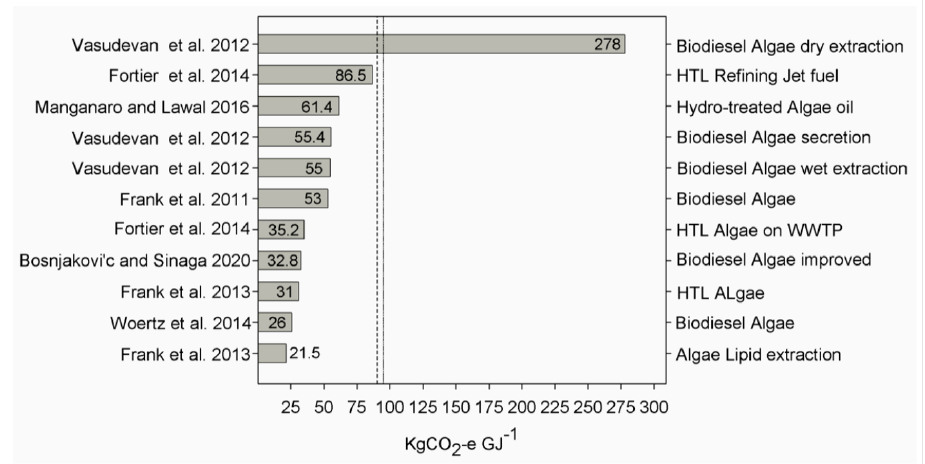
Figure 3. GHG emission footprint of various biofuel options from microalgae fuel models collected from scientific literature